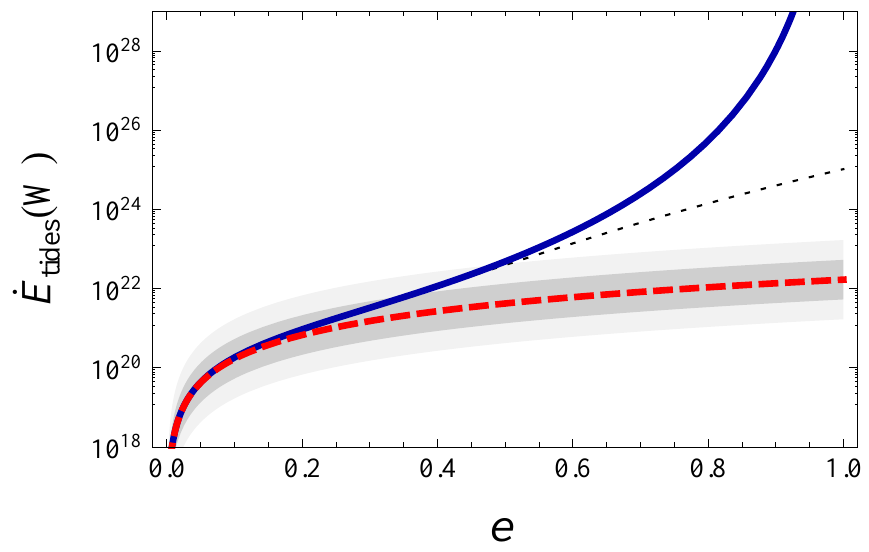
Figure 3: Tidal energy dissipation rate in a pseudo-synchronized planet as a function of the eccentricity calculated with the complete formula (curve), with the e 2 -truncated formula (dash) and to e 10 (Dotted). The ratio of the two curves only depends on the eccentricity and not on the system’s parameters. The inner (outer) shaded area shows the uncertainty in the heating when allowing the dissipation parameter to vary within one (two) order of magnitude. The actual values were derived using HD 209 458 b